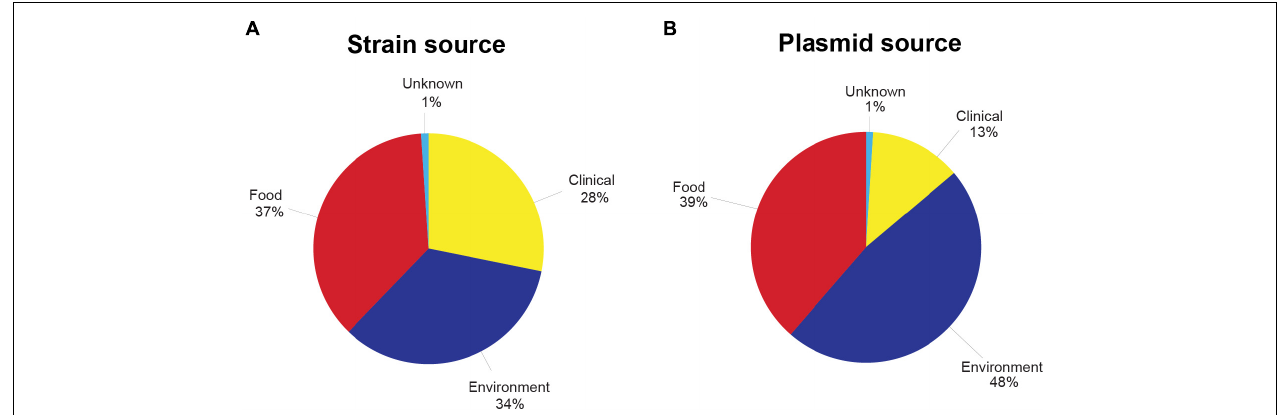
FIGURE 2 | (A) Percentage of Listeria monocytogenes strains used in this study from each source of origin. (B) Percentage of putative Listeria monocytogenes plasmids from each source of origin. Clinical sources included human or animal clinical samples, whereas food sources were isolated from food products. Environmental sources included, but were not limited to, production facilities, environmental swabs, and equipment. See Supplementary Tables 2 and 4 for more details on the strains included and the plasmid-harboring strains.